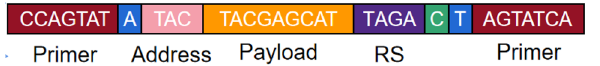
Figure 6. DNA fragment format. The head and tail are primer sequences used to amplify specific file sequences with the PCR technology. The A and T at the ends indicate the direction of the sequence, and Address 17 gives the offset of the data in the file. The middle Payload field is the data payload, and the RS field in purple is the error correction code. Since PCR can amplify the DNA fragments of the data file and the tool file at the same time, the sequencing result may contain both two files, so field C in green indicates whether the fragment belongs to the data file or the tool